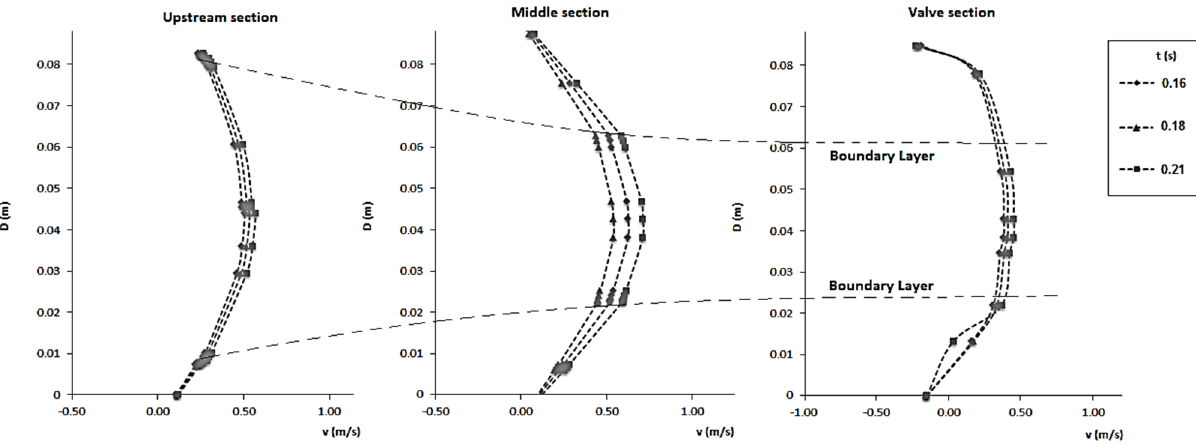
Figure 17. Development of the velocity boundary layer in the three pipe